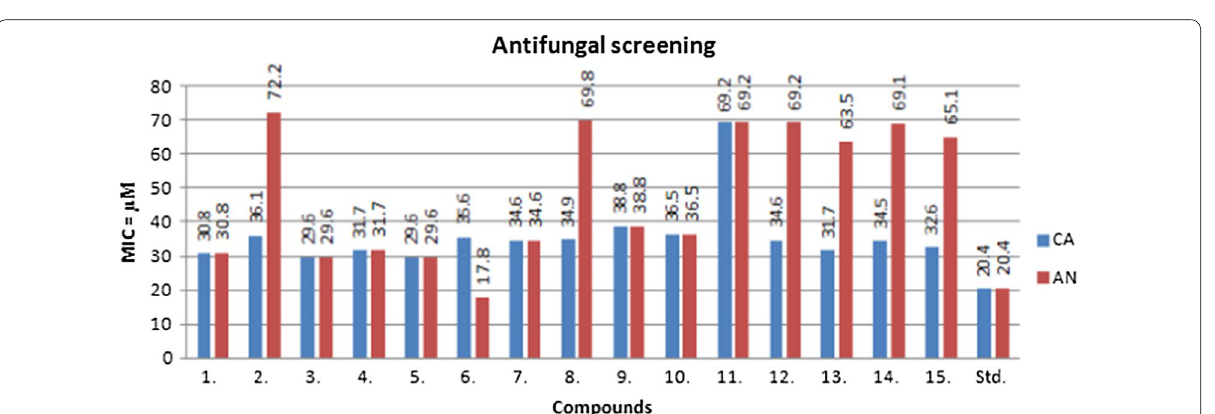
Fig. 5 Antifungal screening results against fungal